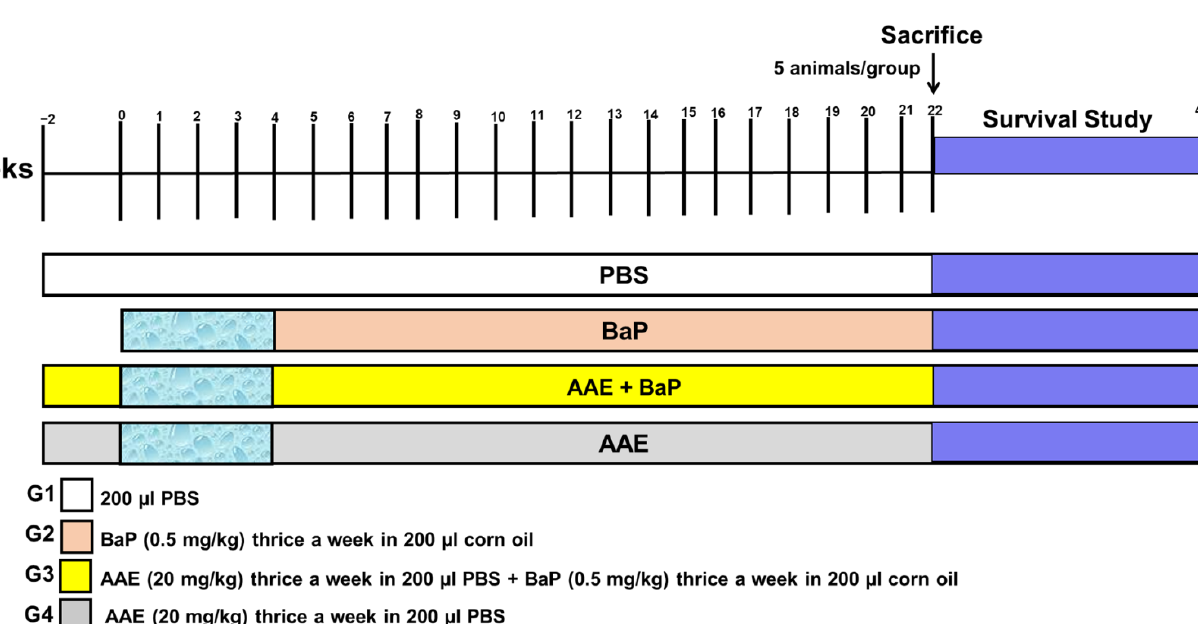
Figure 1. Experimental design of the in vivo studies. G1 (PBS) three times a week from − 2 to week 21. G2 (BaP, 50 mg/kg b.w in 200 µL corn oil) thrice a week from week 0 to week 4. G3 (AAE 20 mg/kg in PBS) as G1 + BaP as G2, and G4 (AAE 20 mg/kg) as G1. All the animals were administered PBS and BaP, as well as AAE, orally.